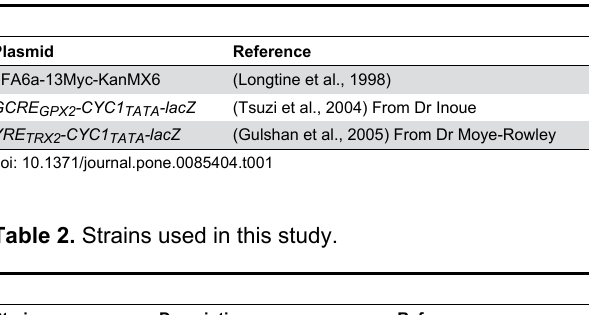
Table 1. Plasmids used in this study.